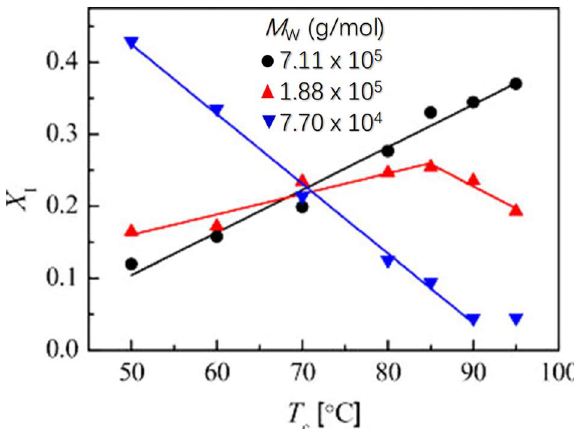
Figure 29. Form I crystal fraction vs. crystallization temperature profiles of iPBu samples with different molecular weight as indicated. The samples were prepared by melting at 160 °C for 8 min to erase the thermal history and then crystallized at different temperatures for the complete the crystallization of form II. The thus prepared sample were annealed at −10 °C for a 60 min nucleation followed by annealing at 40 °C for a 220 min growth of form I crystals. The contents of forms II and I were obtained via melting peak fitting and integrating procedure considering exponentially modified Gaussian functions. Reproduced with permission from Ref. [160], copyright 2017 American Chemical Society.